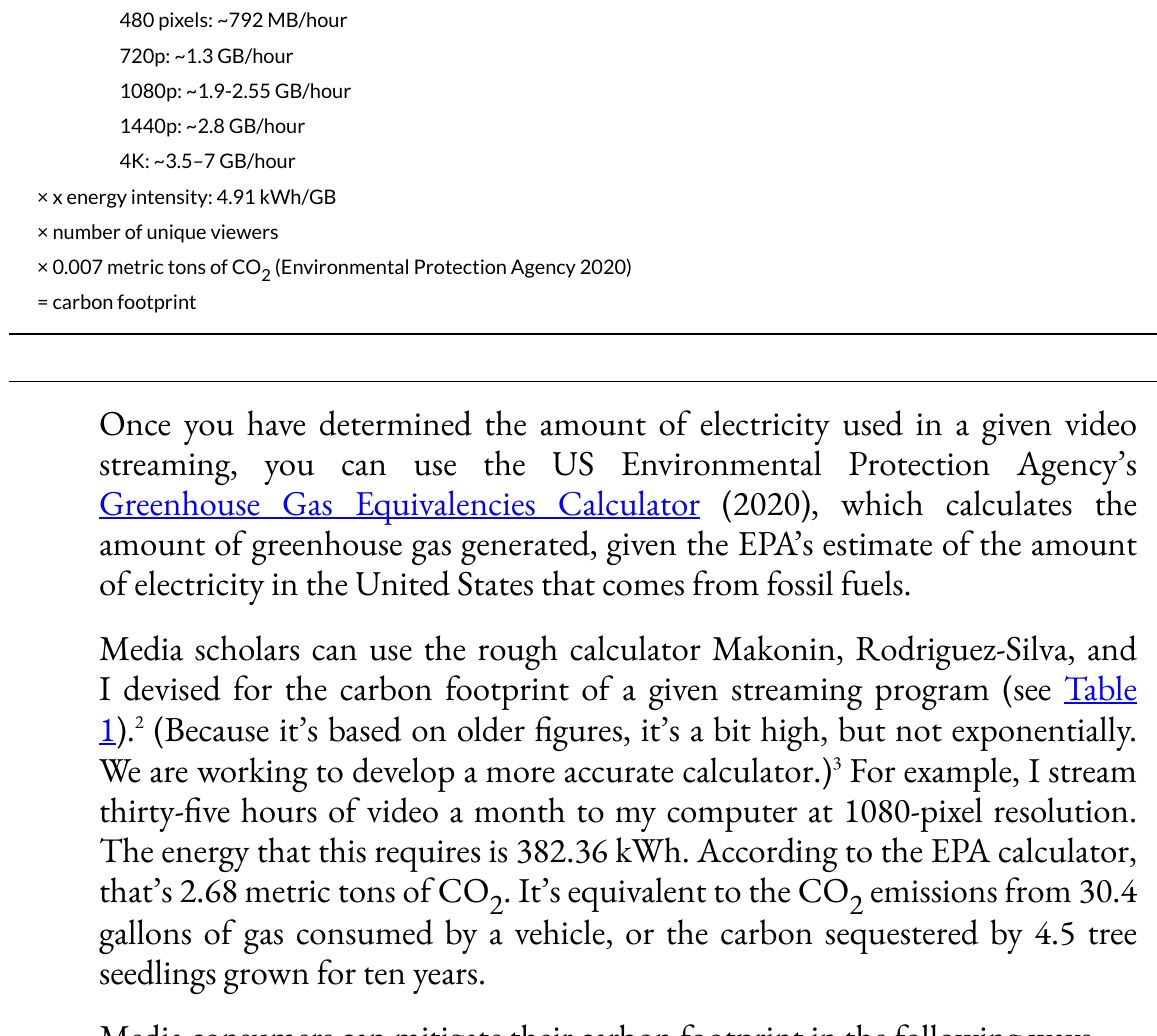
Table 1: Calculating the carbon footprint of a given streaming program Length of the streaming video in hours × GB per hour for a given resolution (Summerson